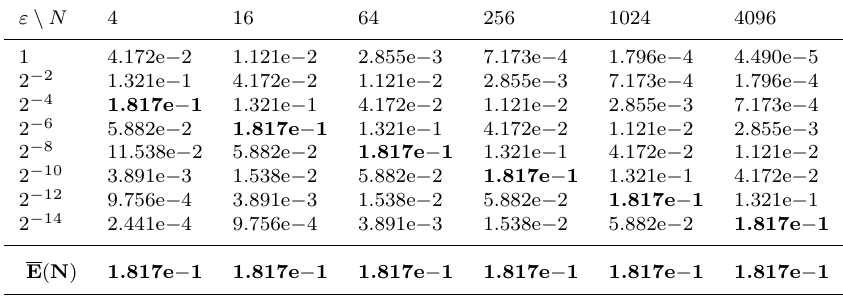
Table 1. Maximum point-wise errors E ( ε, N ) and E ( N ) in the solution of the standard scheme (4.2) on the uniform grid (4.4)